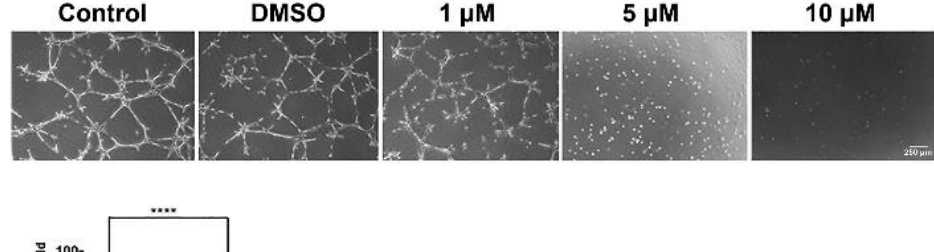
Figure 4. Enantiomers of the phosphorylated S1PR agonist FTY720 inhibit ChEC migration. ChECs in suspension were added to the top of Transwell inserts and incubated for 4 h with medium containing varying concentrations of enantiomer (in DMSO) or DMSO. Cells were fixed, stained with H&E, and the number of cells that migrated through the 8 μm pore size membrane was counted as described in Methods. **** p < 0.0001. ( n = 3).